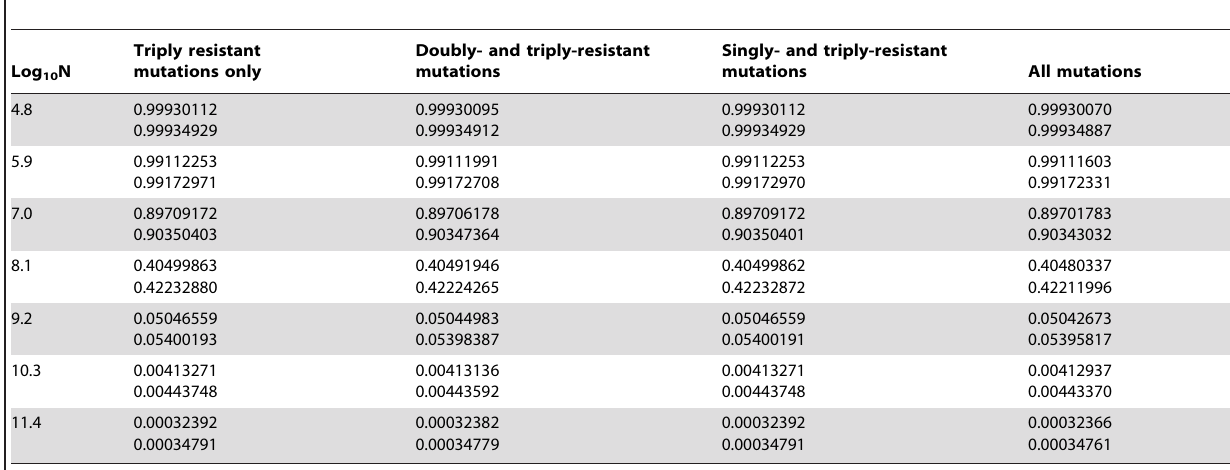
Table 3. Probability of treatment success for a three drug combination treatment with different mutations ‘‘on’’ and ‘‘off’’.